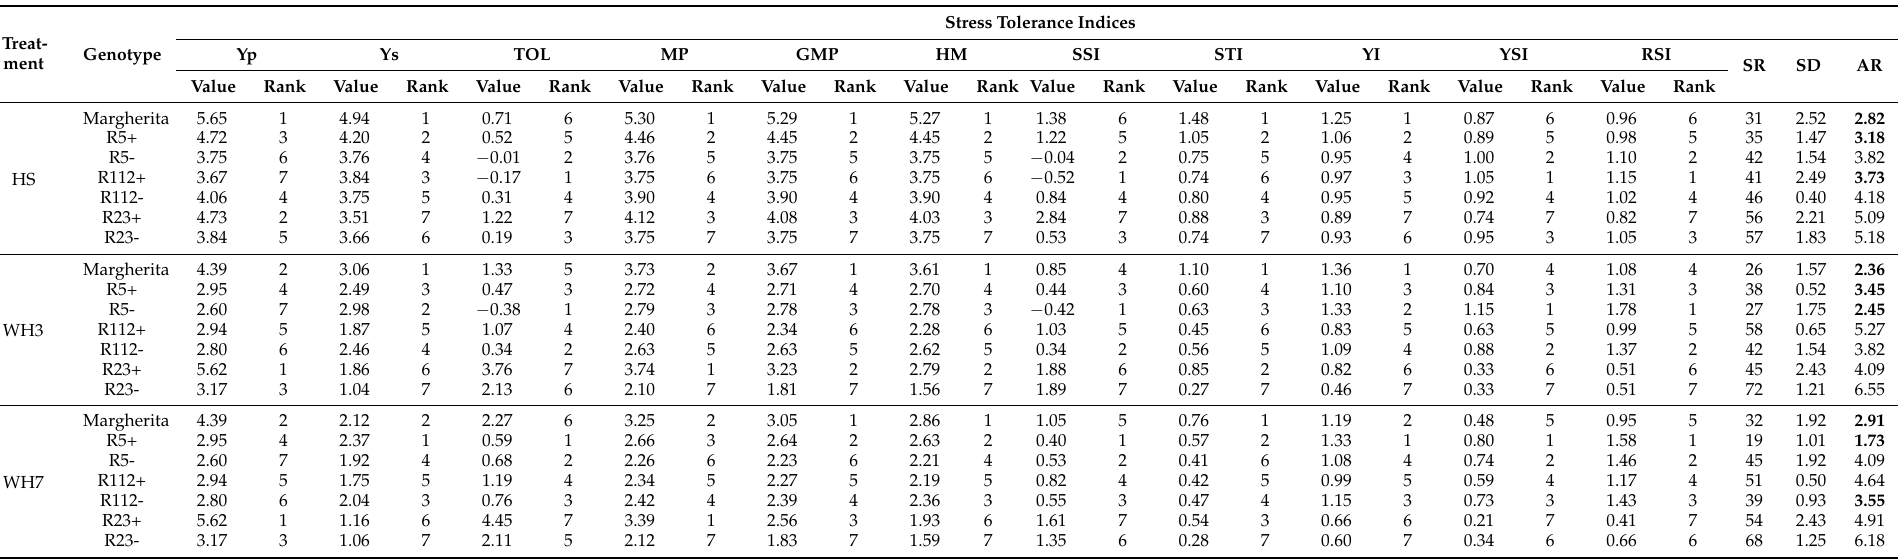
Table 5. Stress indices’ values and ranking of the genotypes tested in the three stress experiments performed: HS, heat stress; WH3, water-deficit + 3-day heat stress; and WH7, water-deficit + 7-day heat stress. The best value for each index appears in bold. For acronyms of the stress indices see the Materials and Methods section; SR, sum of ranks; SD, standard deviation; AR, average of